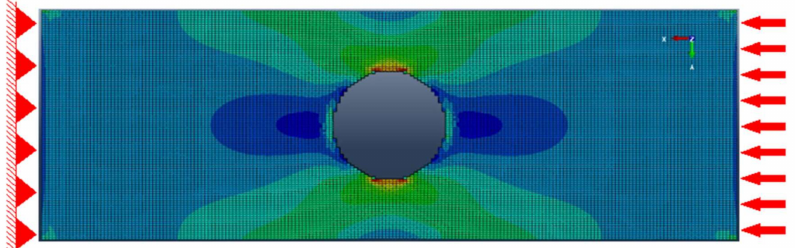
Figure 20. Stress distribution of the plate printed based on optimized tool-path.